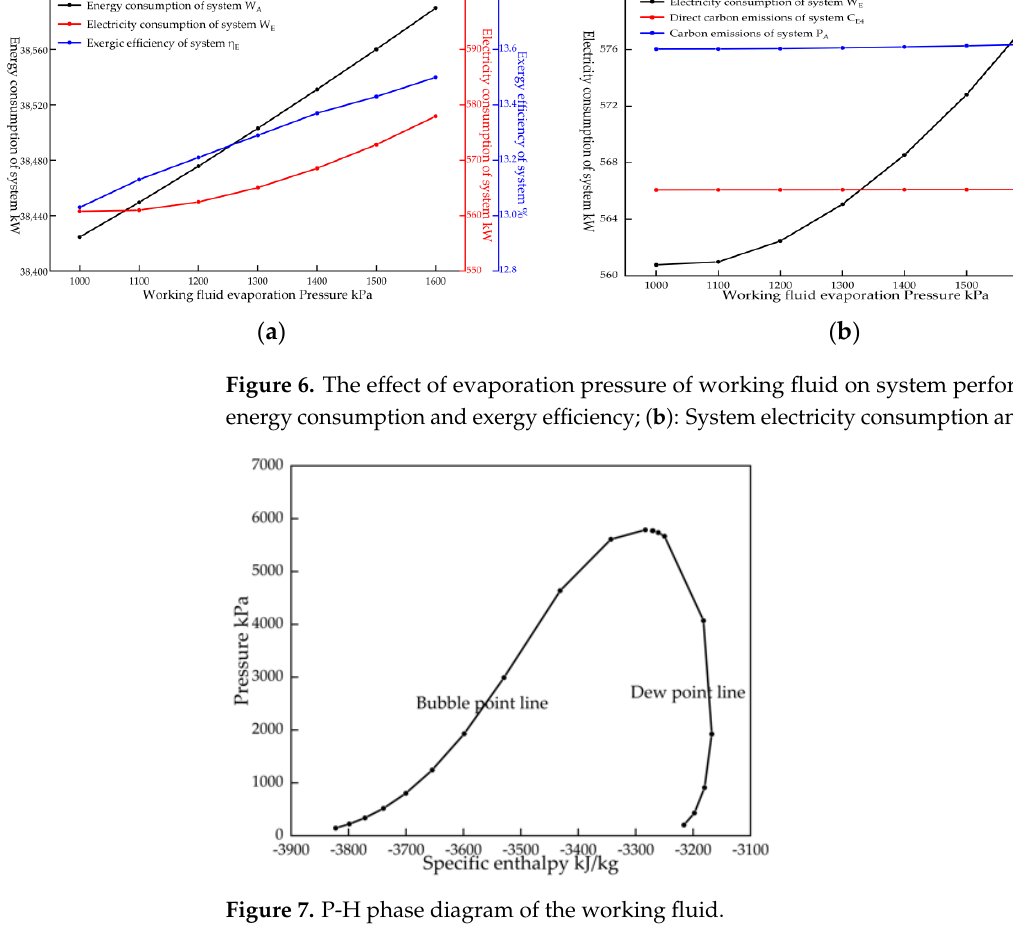
Figure 7. P-H phase diagram of the working fluid.